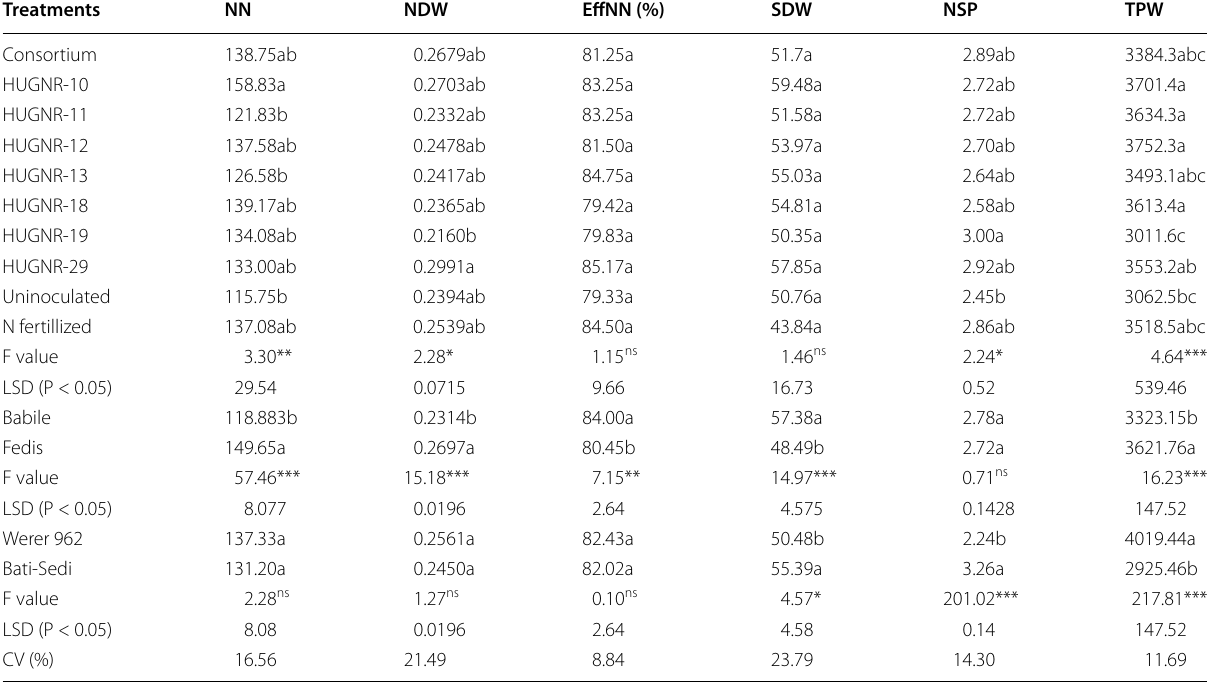
Table 2 Nodulation traits, shoot dry weight, number of seeds per pg and total pegs weight as affected by Bradyrhizo- bium inoculation, cultivar, and